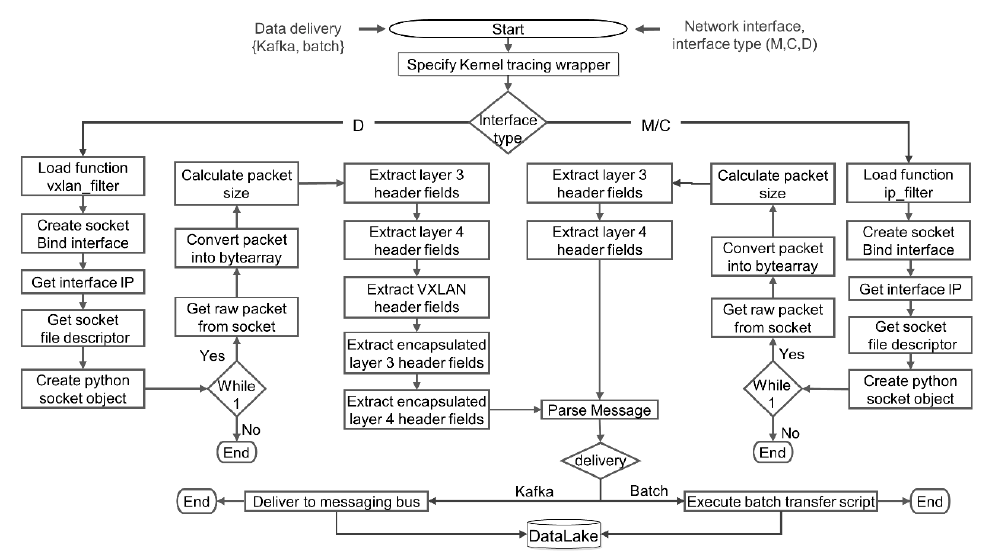
Figure 4. Design of network packets flow collection component.